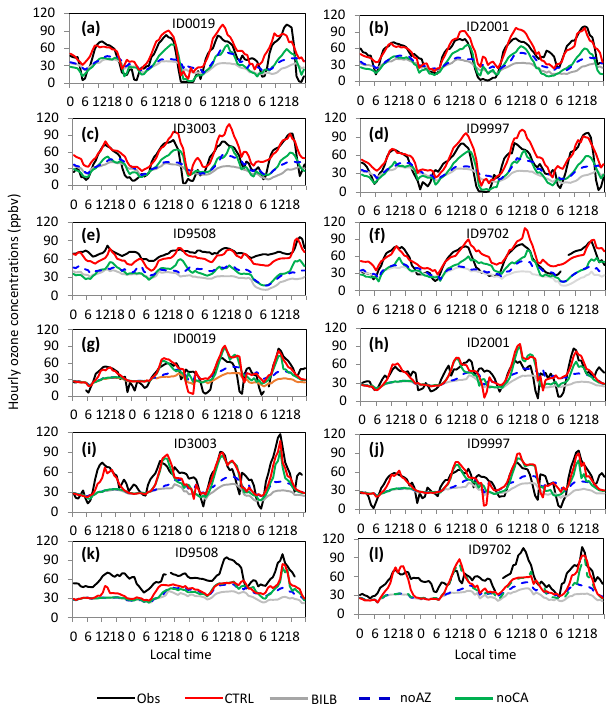
Figure 4. Relative contributions of different emission scenarios to [O 3 ] at observation sites in Phoenix metropolitan area and sur- rounding rural areas. The dates are 11–14 May 2012 (a–f) and 16– 19 July 2005 (g–l) . Idxxxx corresponds to the EPA AIRS site num- ber in Maricopa County, Arizona. Black line indicates the [O 3 ] ob- servation. Red line represents the simulated [O 3 ] for the CTRL run. Blue line shows the [O 3 ] for the noAZ run. Green line displays the [O 3 ] for the noCA run. Gray line is the [O 3 ] for the BILB run.